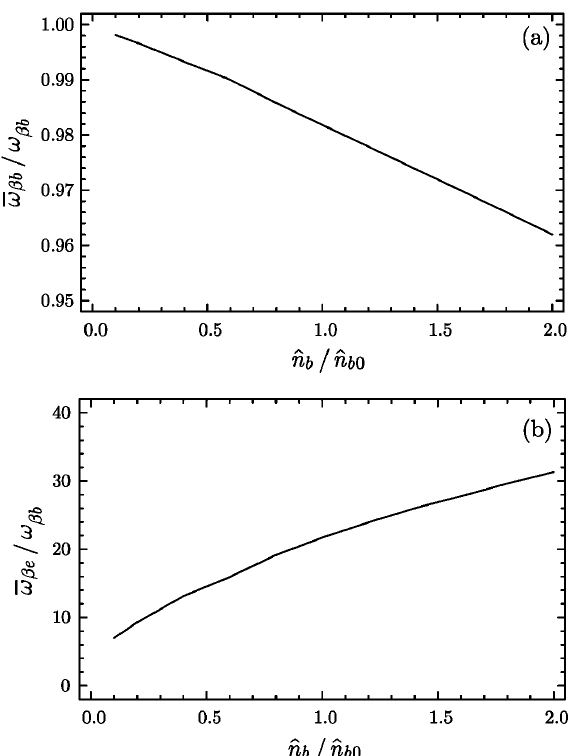
FIG. 7. Average transverse oscillation frequencies versus nor- malized beam intensity for the (a) protons and (b) electrons.